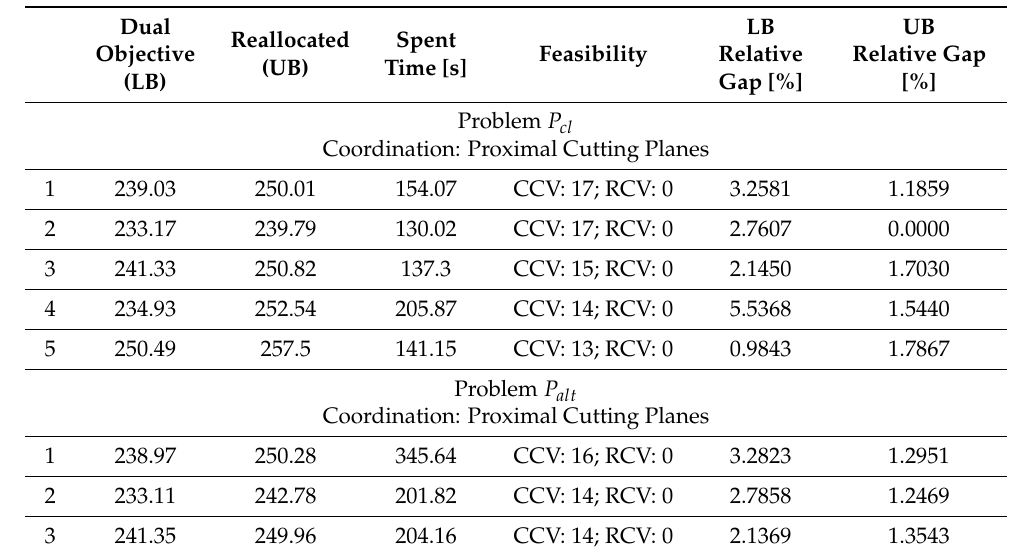
Table 9. Numerical results for large problems—demands decomposition.